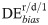
Distributions of HV across problem sizes 5 × 5 through 7 × 7 for DE, DE with the r/d/1 local search variant, DEbias, DEbiasr/d/1 and DEbiasr/d/3*.Also plotted are the HVs of the earlier ACO (using three different greediness settings) with local search.